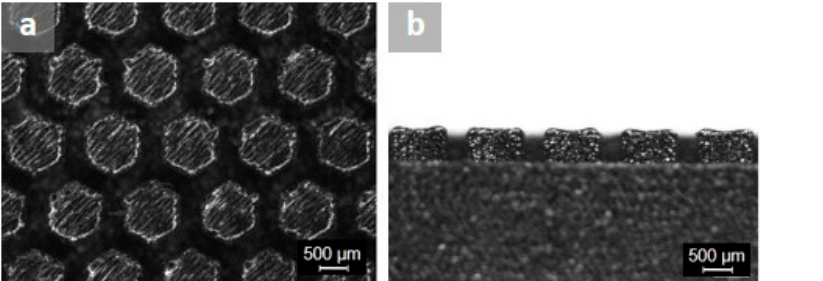
Figure 3. Samples from Scale 3 ( a ) Hex, ( b ) Hex-D.